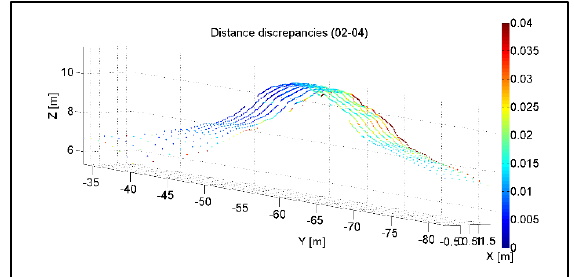
Figure 5. Distance discrepancies between Dec. 2 nd and 4 th with colour bar changing from 0 to 4 cm